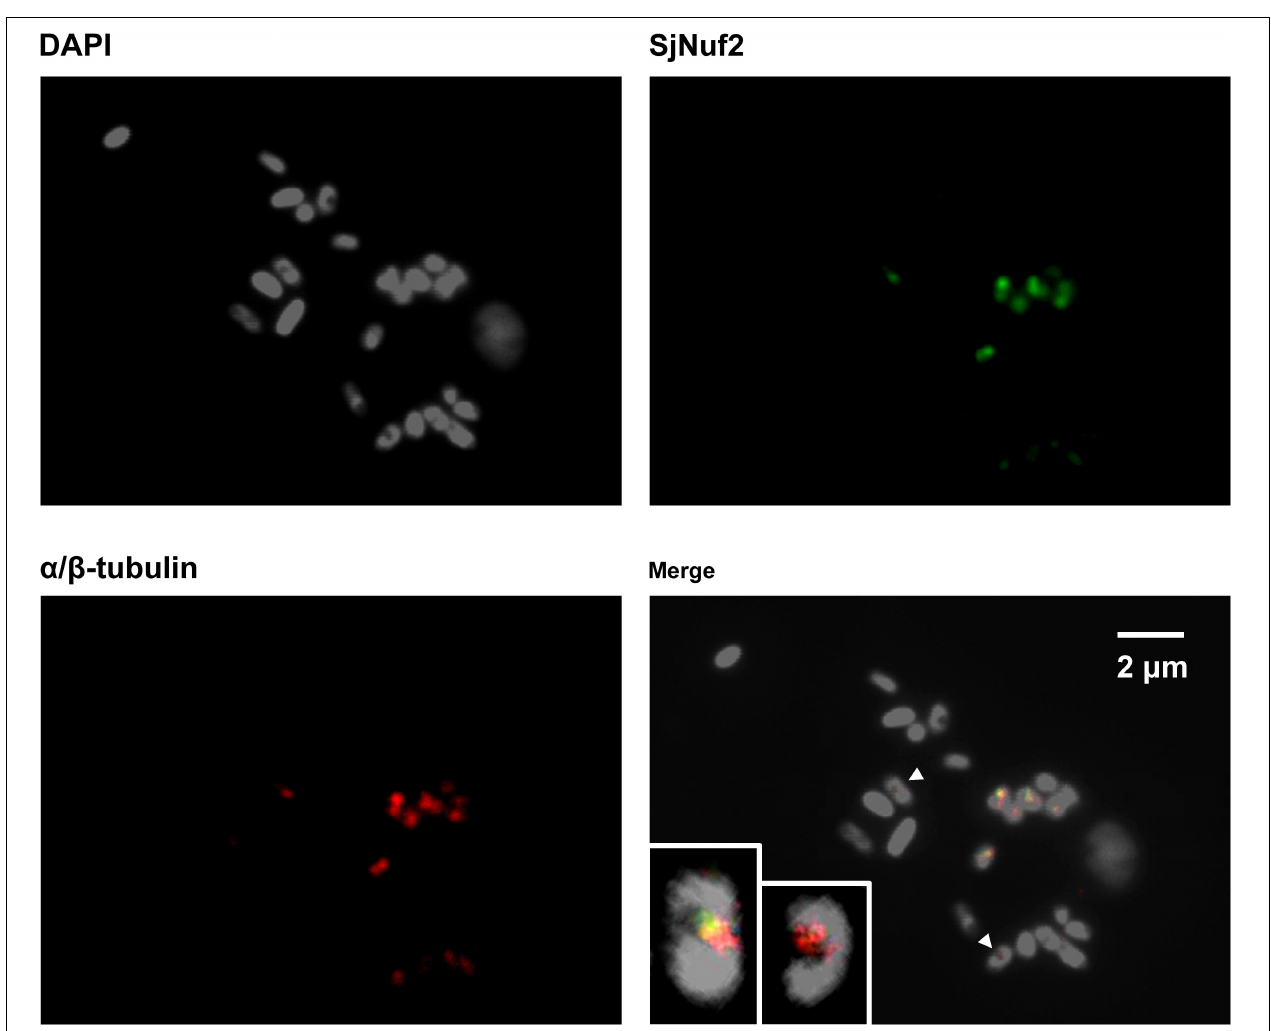
FIGURE 5 | Immunofluorescence images showing the co-localization of SjNuf2p (green) and α / β -tubulin (red) on Saccharina cultivar chromosomes counterstained with 4 (cid:48) ,6-diamidino-2-phenylindole (DAPI) (gray). The insets in the merged image clearly illustrating that the signals are present at the centromeres of two selected chromosomes as indicated by